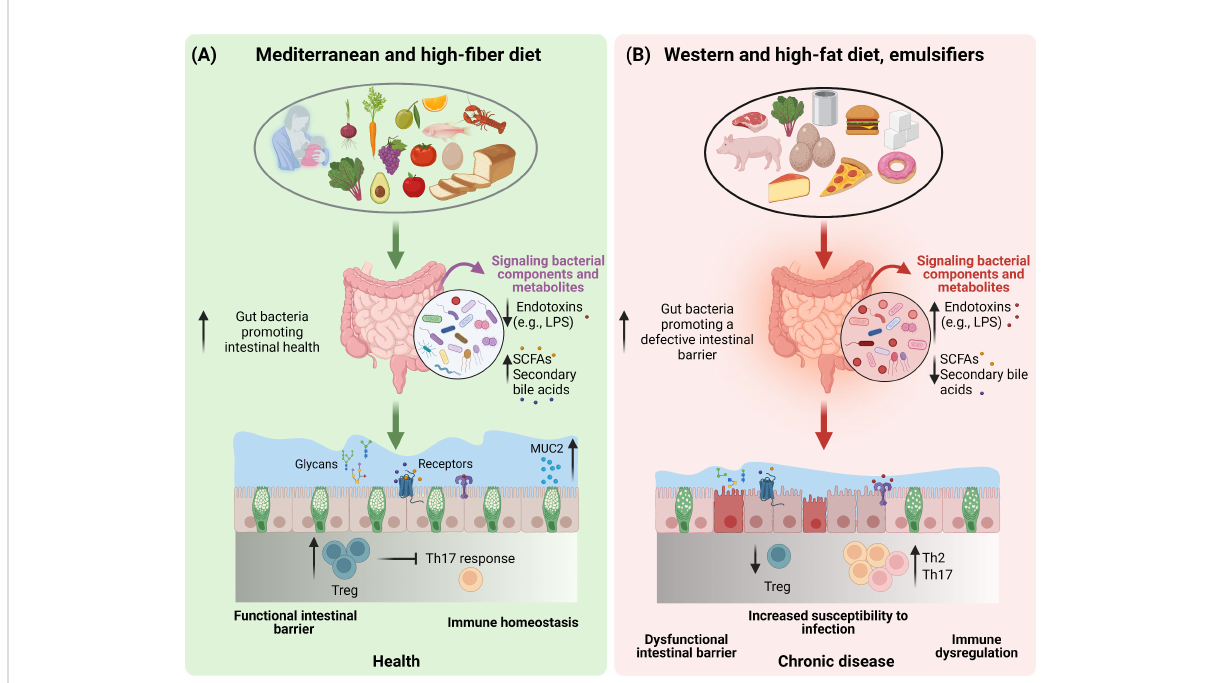
FIGURE 1 The impact of dietary patterns on gut microbiota and intestinal health. A schematic overview depicting the importance of diet and dietary constituents in discriminating between a healthy (A) or an unhealthy (B) state of the gut barrier function by modulating the composition and functionality of the gut